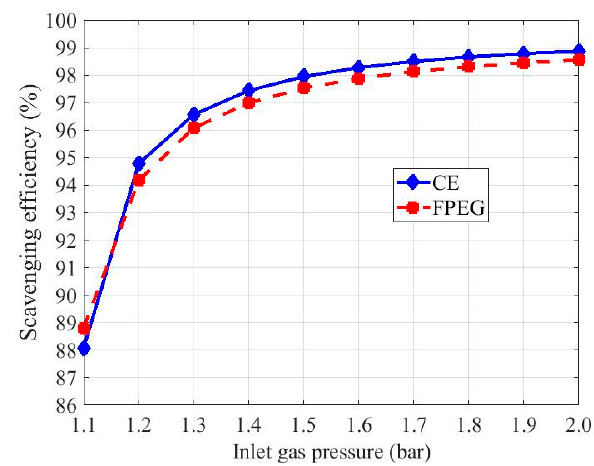
Figure 10. Scavenging efficiency with different intake pressures.